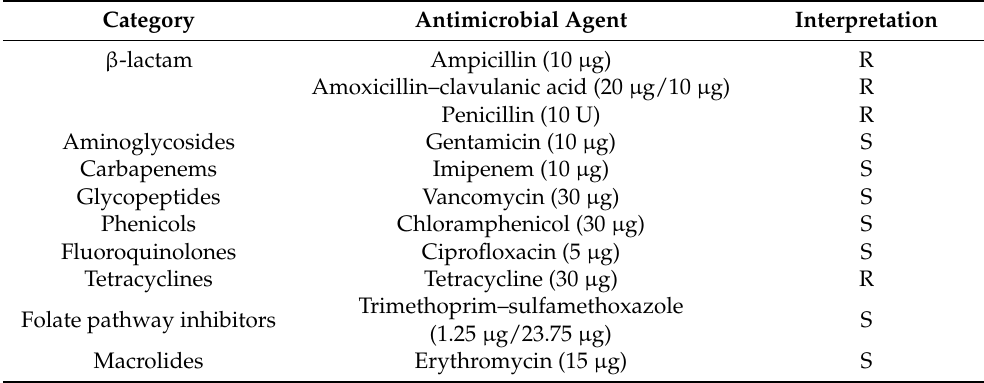
Table 1. Antimicrobial susceptibility testing of Bacillus sp. B87.